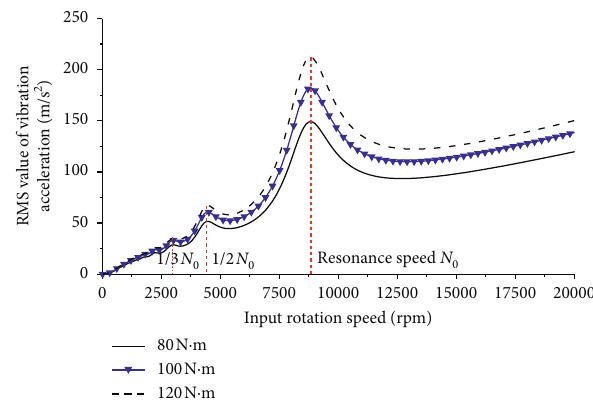
Figure 20: The vibration acceleration diagram under excitation of both for single-stage gear transmission system.